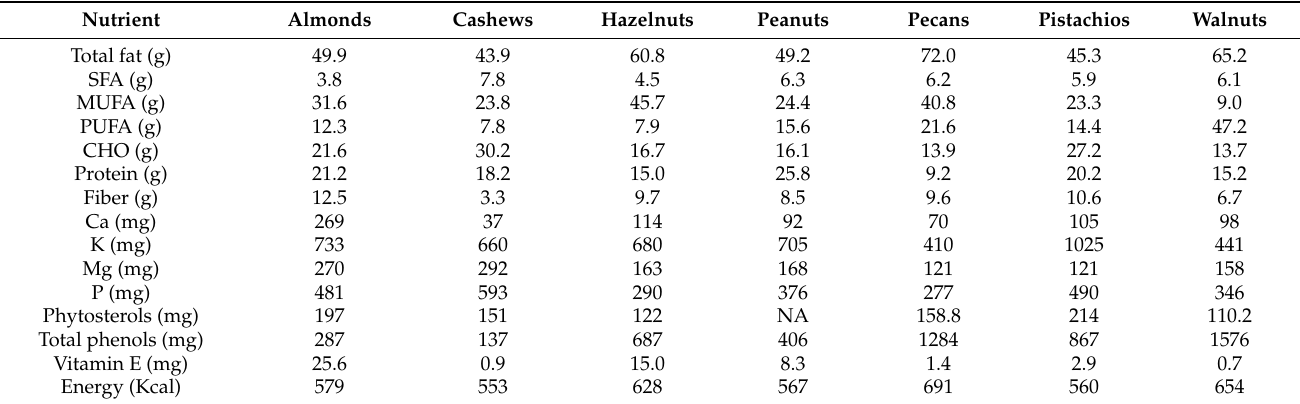
Table 1. Main nutrients in different types of nuts (per 100 g of raw nut)